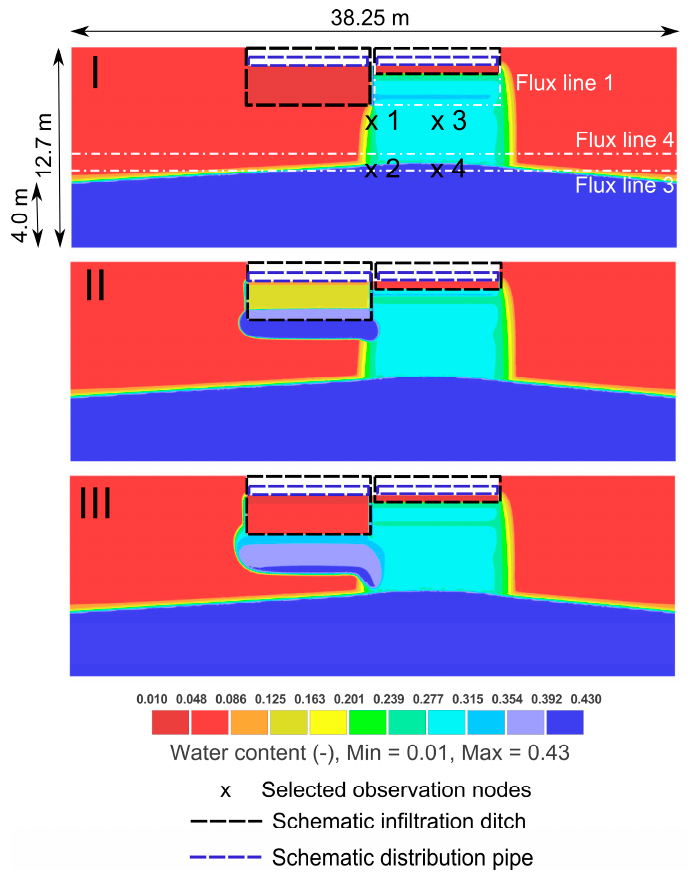
Figure 3. Water contents in the reference model: (I) before precipitation water event, (II) directly after precipitation event, and (III) approximately 0.5 days after the beginning of precipitation event. Flux line 2 is vertically located between the infiltration ditches in the center of the hydraulic barrier.